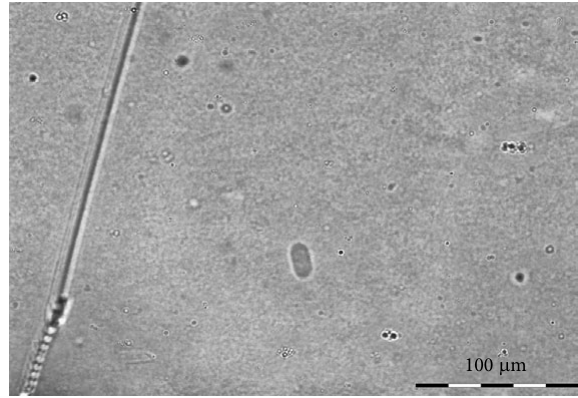
Fig. 3. Photographic recording of the E 160V55 film – smooth surface of the hardened new dispersion film (50-fold